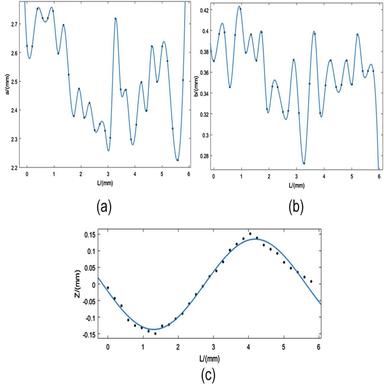
Yarn parameter statistics: (a) Systematic curve of major axis; (b) Systematic curve of minor axis; (c) Systematic curve of yarn path coordinates.